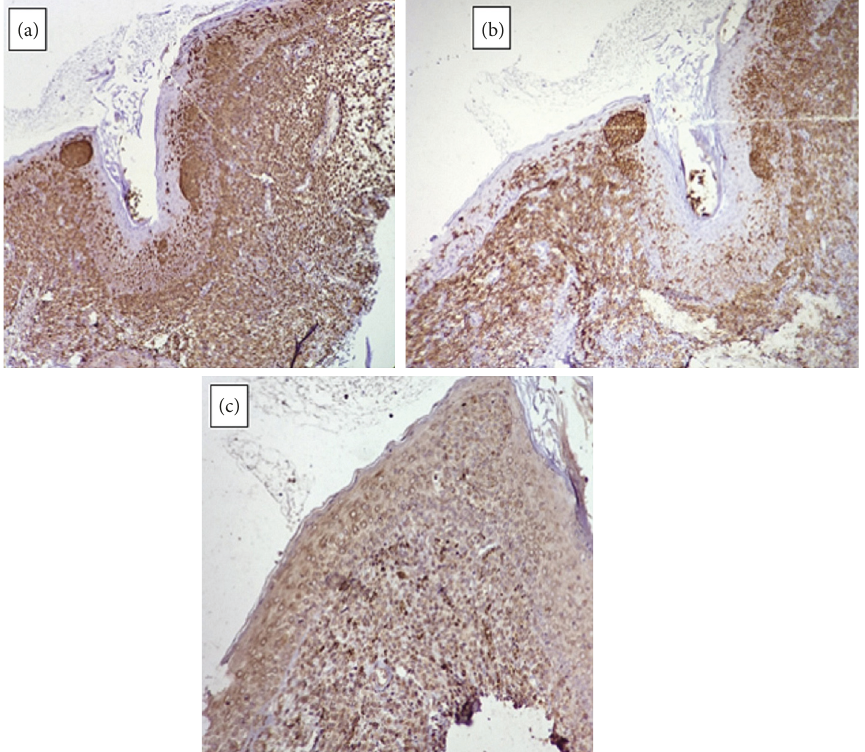
Figure 3: (a). S100 immunostaining shows strong diffuse positivity in upper dermis and scattered single as well as aggregates of Langerhans cells in the epidermis ( × 100) (b). CD1a immunostaining of Langerhans cells shows strong diffuse positivity in the upper dermis and scattered single as well as aggregates in the epidermis ( × 100) (c). CD68 immunostaining shows scattered weak positivity upper dermis ( × 100).